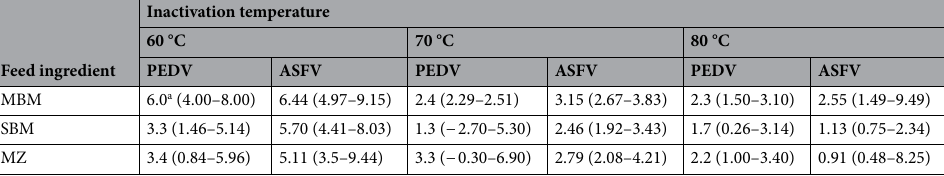
Table 6. Comparing D T (min) of PEDV and ASFV in feed ingredient at 60, 70, and 80 °C a mean (95% confidence